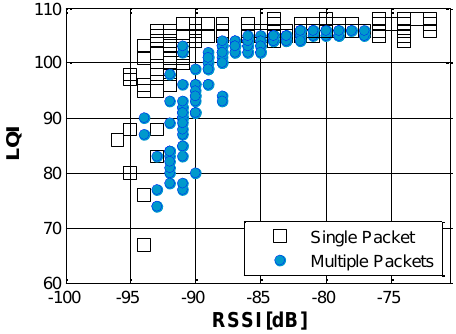
Figure 4. Relationships of RSSI and LQI in comparison between single and multiple packets being used in the communication.